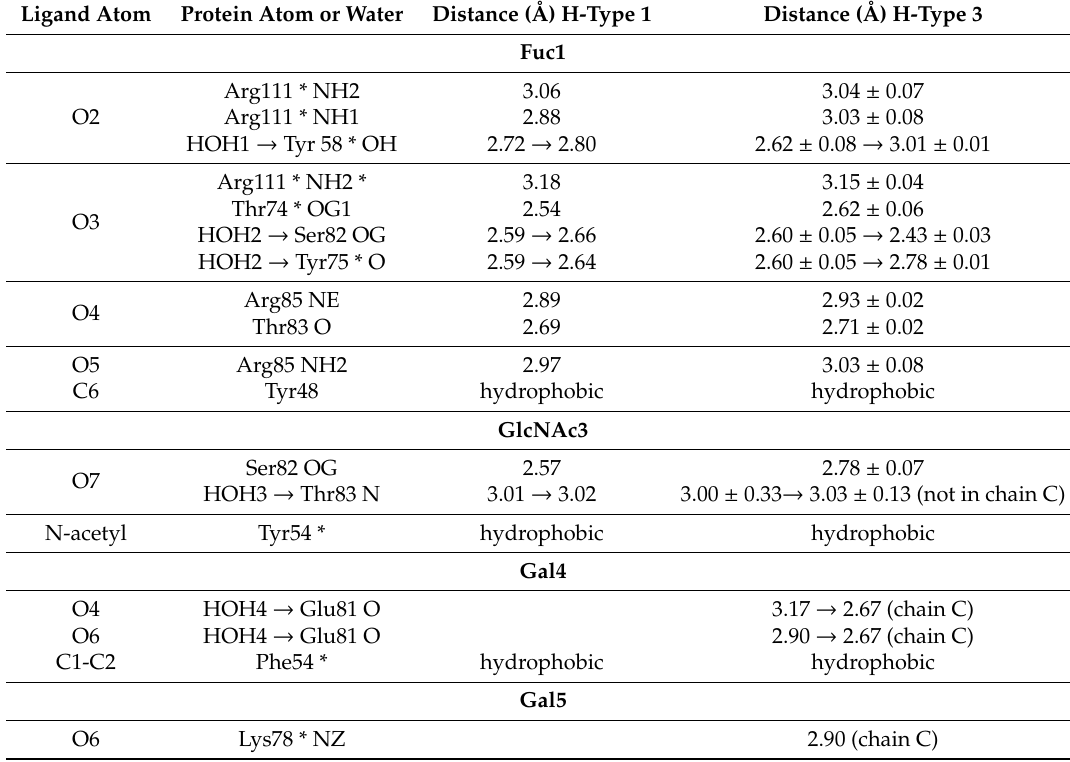
Table 3. Summary of the interactions of BC2L-CN2 with